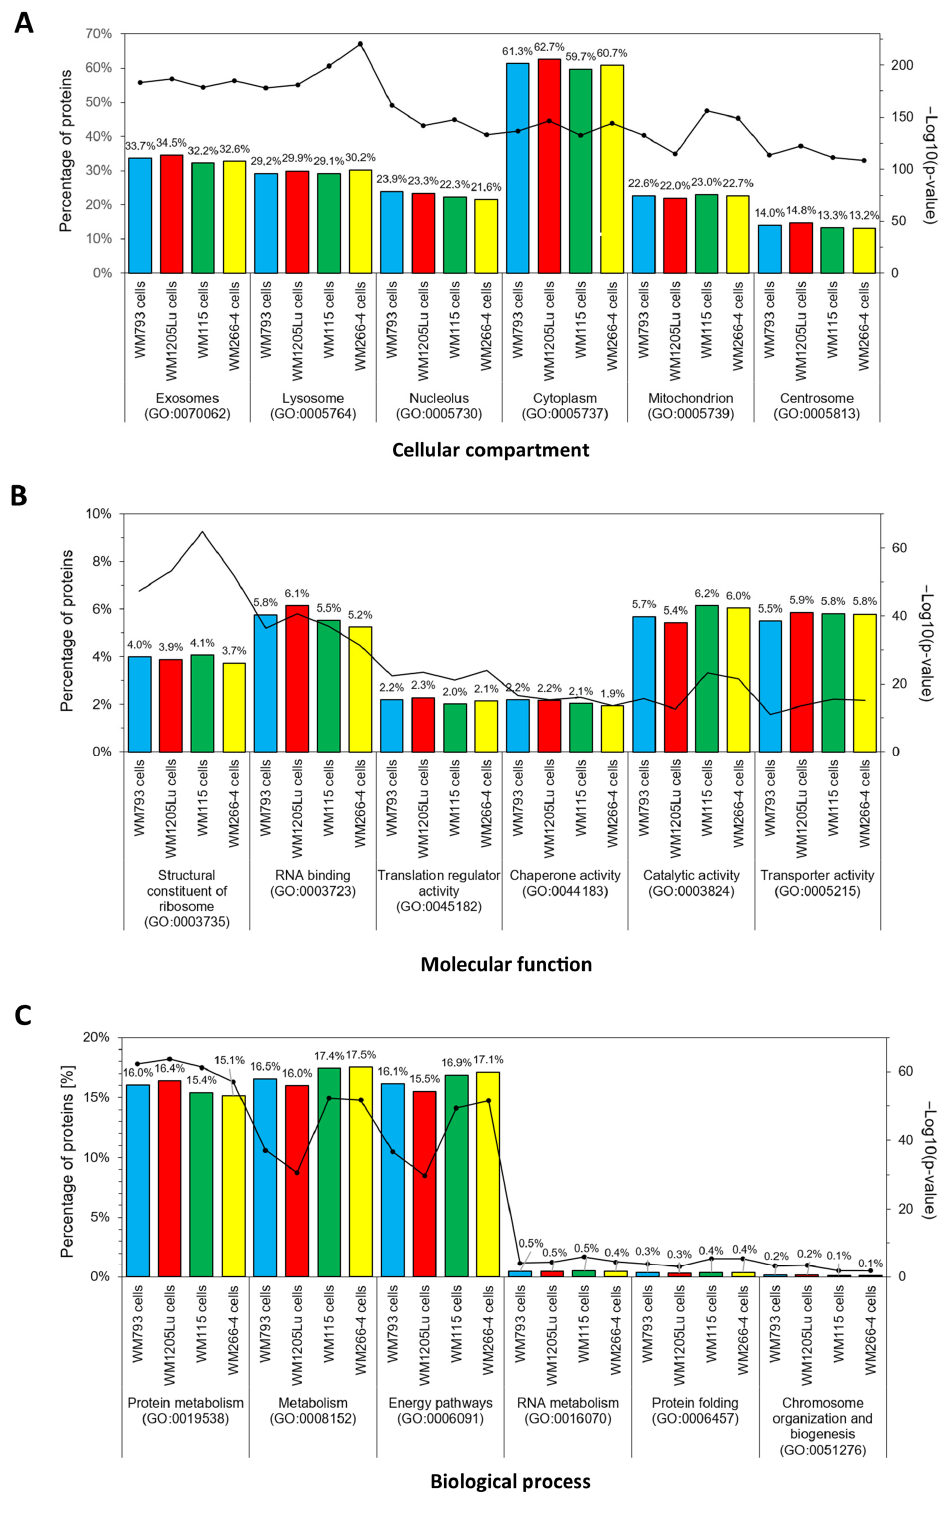
Figure 6. GO analysis regarding “Cellular compartment” ( A ), “Molecular function” ( B ), and “Biological process” ( C ) of proteins identified in CM cell lines. FunRich 3.1.3. software with the UniProt